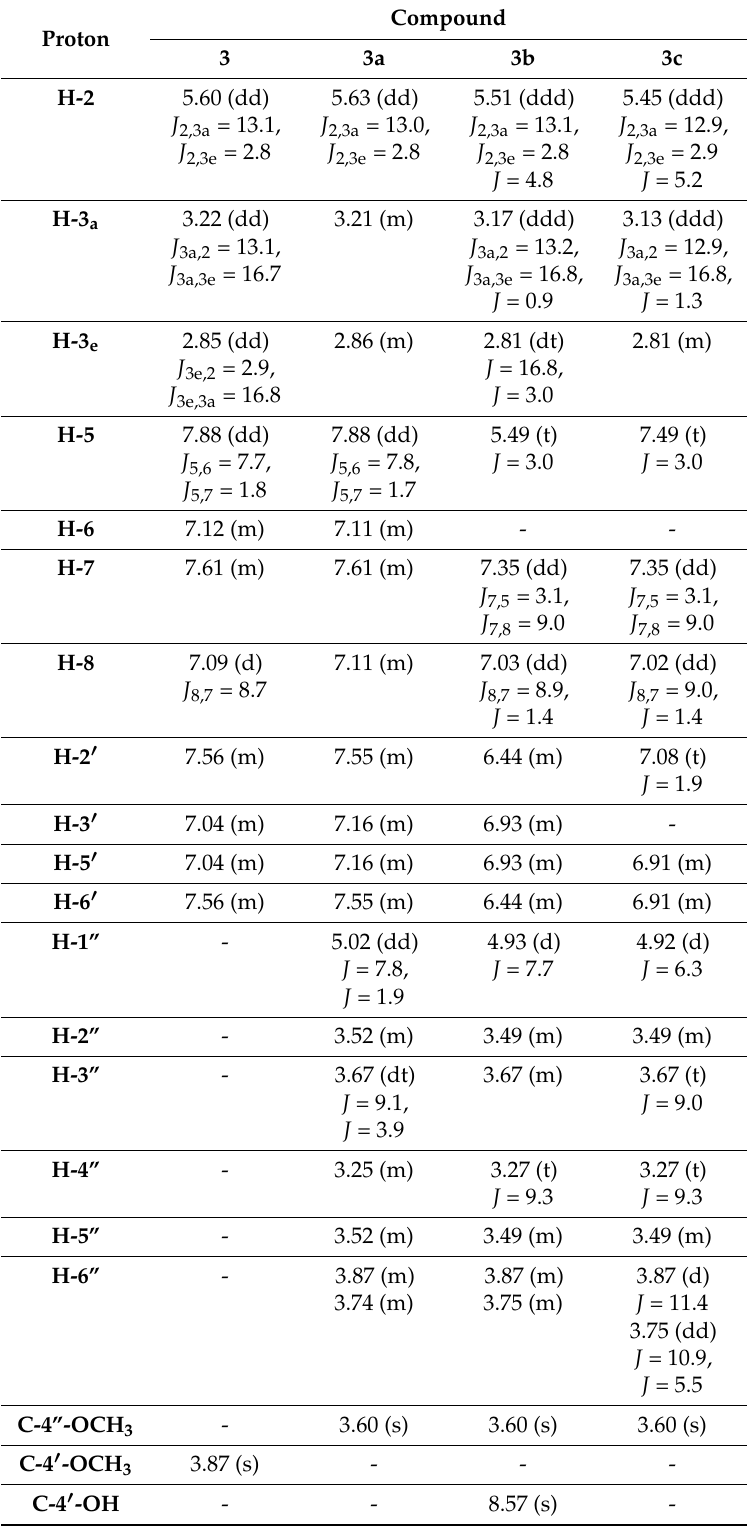
Table 3. The 1 H-NMR shifts ( δ ) (ppm) and coupling constants ( J H,H ) (Hz) of 4 (cid:48) -methoxyflavanone ( 3 ) and the products of its biotransformations ( 3a , 3b , 3c ) in Acetone-d 6 , 600 MHz (Supplementary